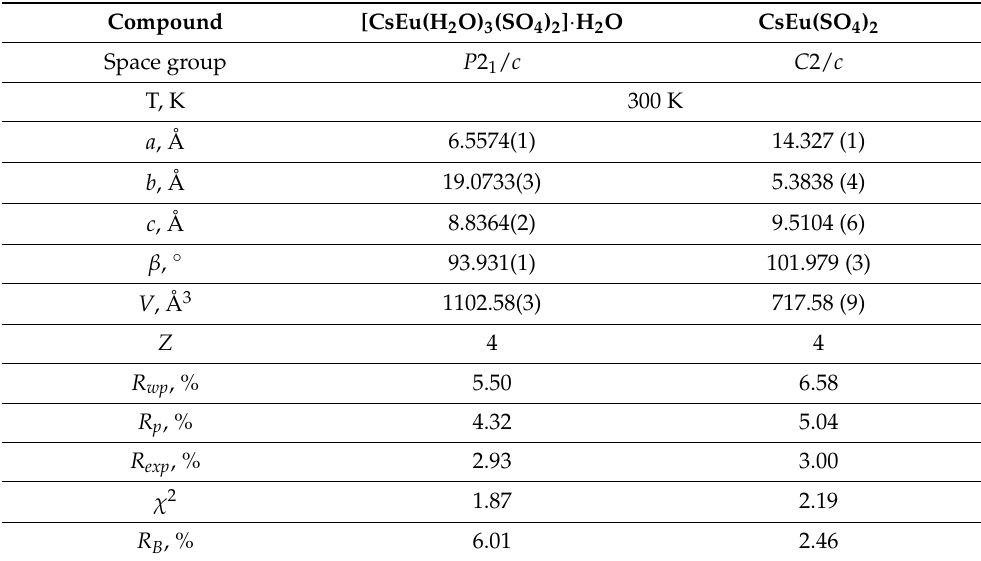
Table 1. Main parameters of processing and Rietveld refinement of the [CsEu(H 2 O) 3 (SO 4 ) 2 ] · H 2 O and CsEu(SO 4 ) 2 powder